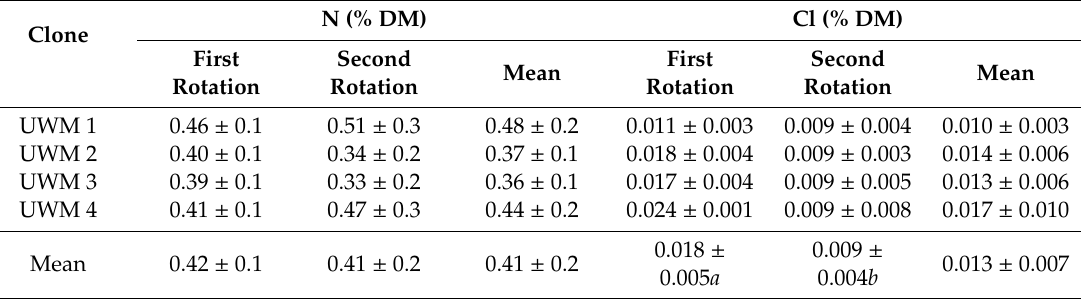
Table 6. Content of nitrogen (N) and chlorine (Cl) in biomass of four poplar clones in two consecutive 4-year harvest rotations.